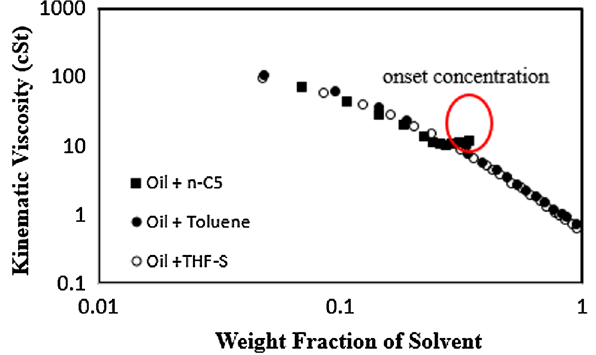
Fig. 6 Kinematic viscosity of Maya crude–solvent mixture versus